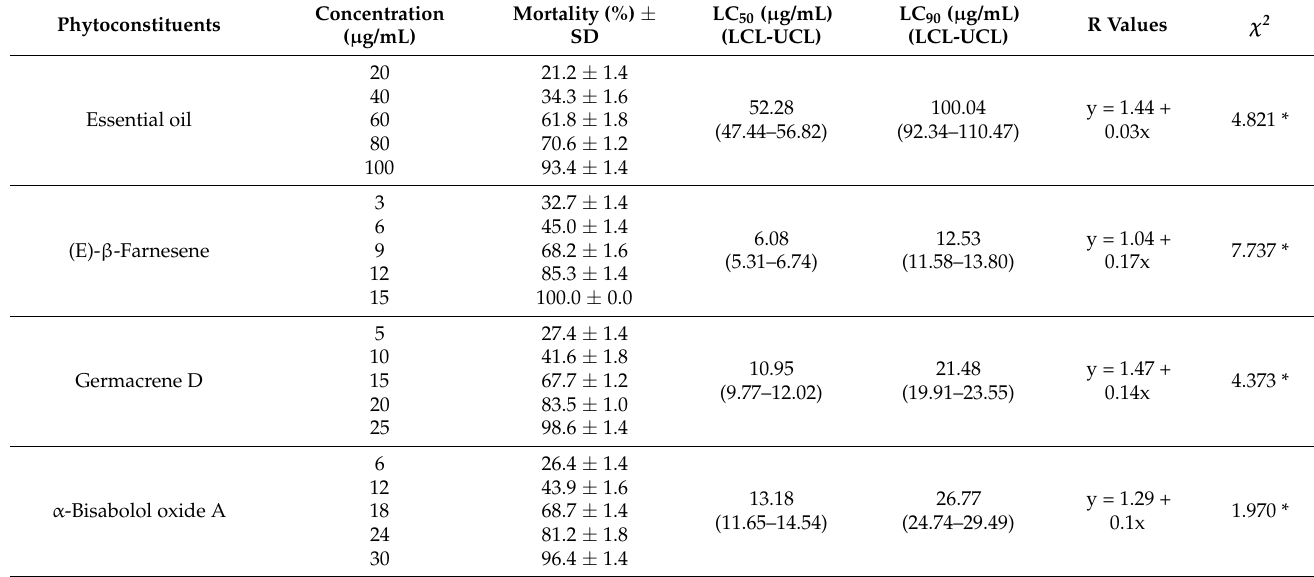
Table 5. Larvicidal activity of Matricaria chamomilla essential oil and its major phytoconstituents against 3rd-instar larvae of Anopheles subpictus